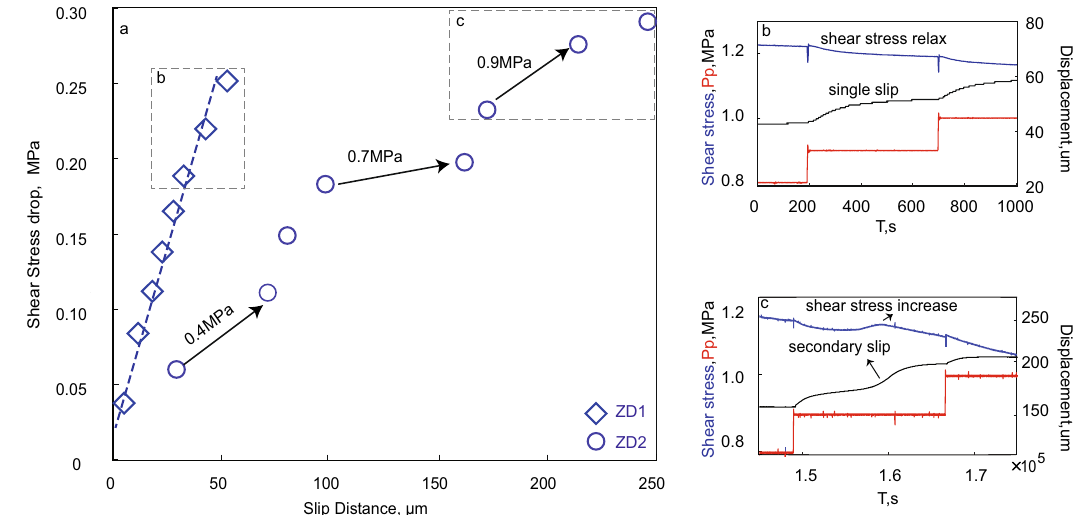
Fig. 2 Shear stress drop/relaxation during fl uid pressurization. a Shear stress drop vs. slip displacement for tests ZD1 and ZD2. Experiment ZD1 shows a constant slope during fl uid pressurization, while ZD2 features slope changes for the 0.4, 0.7, and 0.9 MPa pressurization steps. Pressurization step at 0.9 MPa for ZD1 ( b ) and ZD2 ( c ) are shown for comparison.